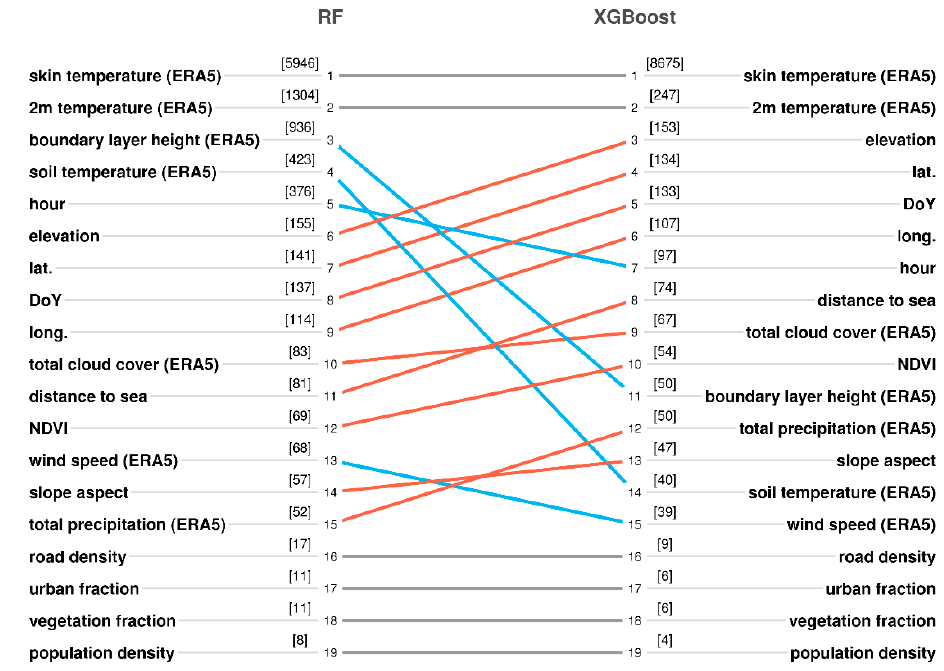
Figure 5. Importance of features incorporated in the Stage 1 models and the relative ranking changes of each feature between random forest (RF) and extreme gradient boosting (XGBoost). The values in brackets denote the relative feature importance averaged over all years for each model with a scaling factor of 10 − 4 .